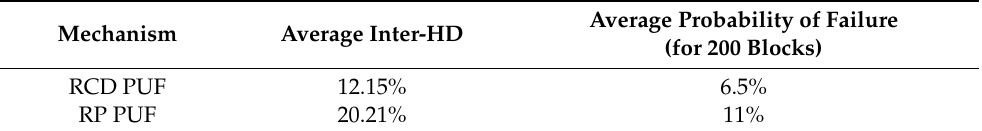
Table 2. Average inter-HD for t RCD and t RP PUFs.